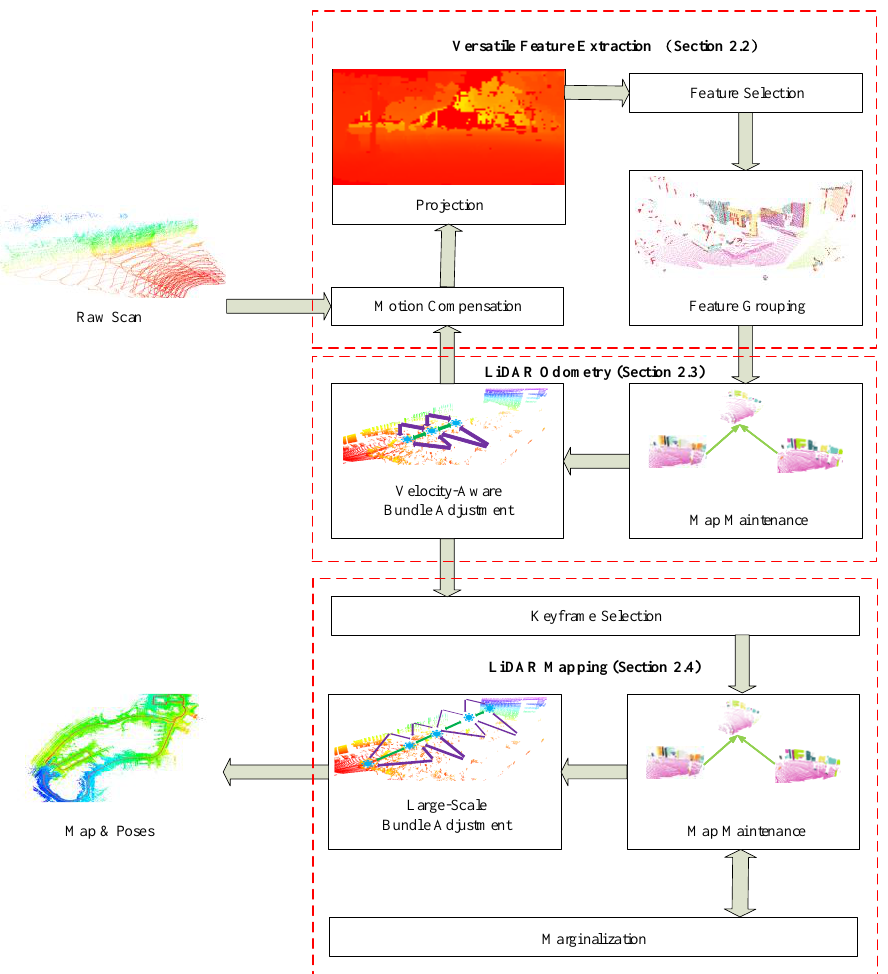
Figure 2. Overview of our SLAM system, which has three main parts: a versatile feature extraction module, a LiDAR odometry module, and a LiDAR mapping